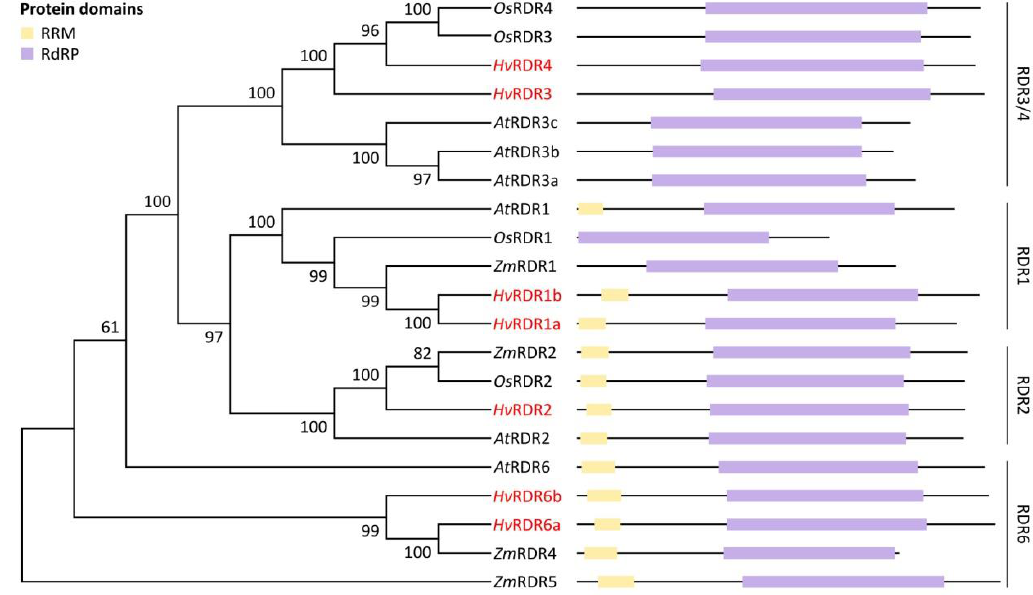
Figure 4. Phylogenetic relationship and conserved domains of A. thaliana , O. sativa , Z mays and H. vulgare RDR proteins. Unrooted NJ trees were constructed with MEGA X software as described in Figure 1 legend. The bootstrap values are shown next to the branches. Conserved domains were identified with the SMART server [84]. The protein domain abbreviations are the followings: RRM (RNA-recognition motif), RdRP (RNA-dependent RNA polymerase domain). The barley RDRs identified in this study are marked with red.